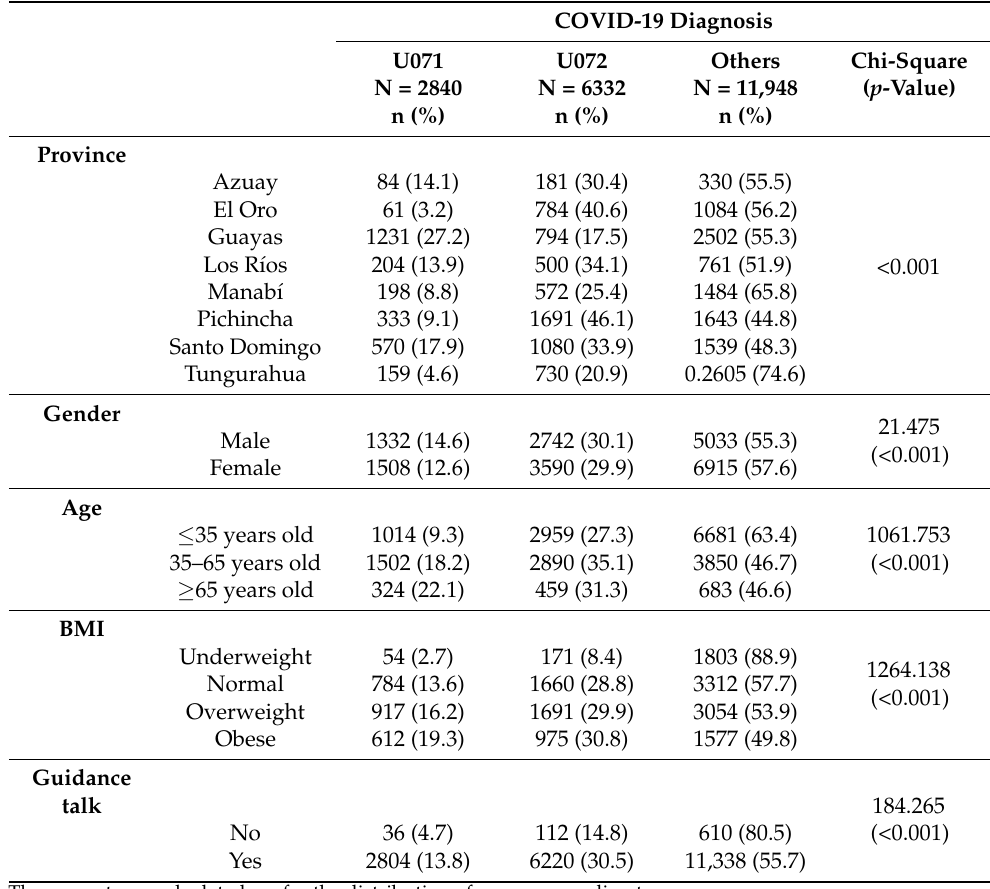
Table 2. Type of diagnosis and severity level according to sociodemographic